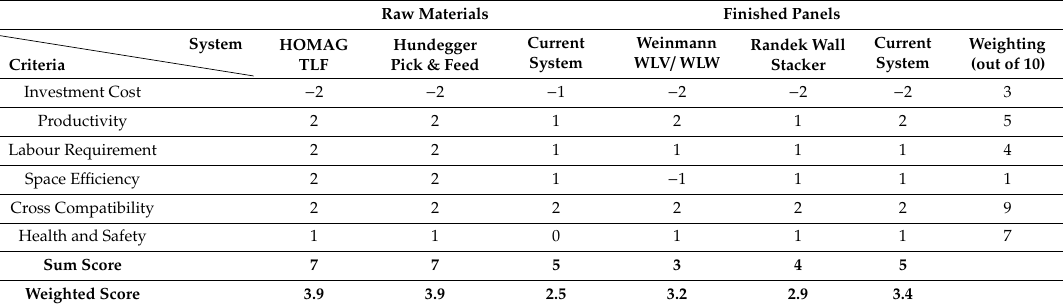
Table 11. Resultant scores for the storage and handeling system.